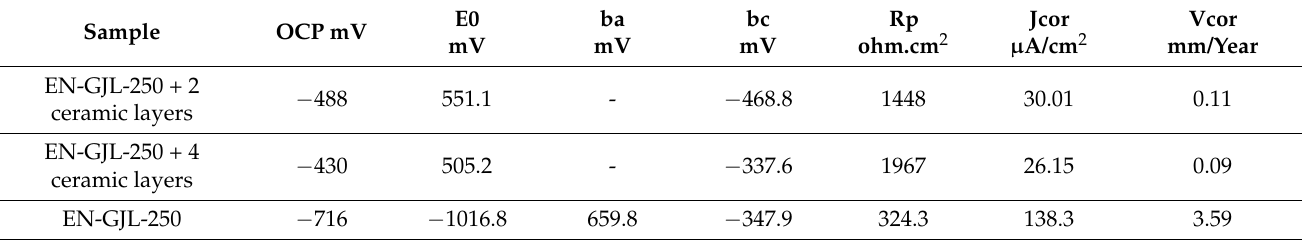
Table 2. Electrochemical parameters after the corrosion tests in acid rain